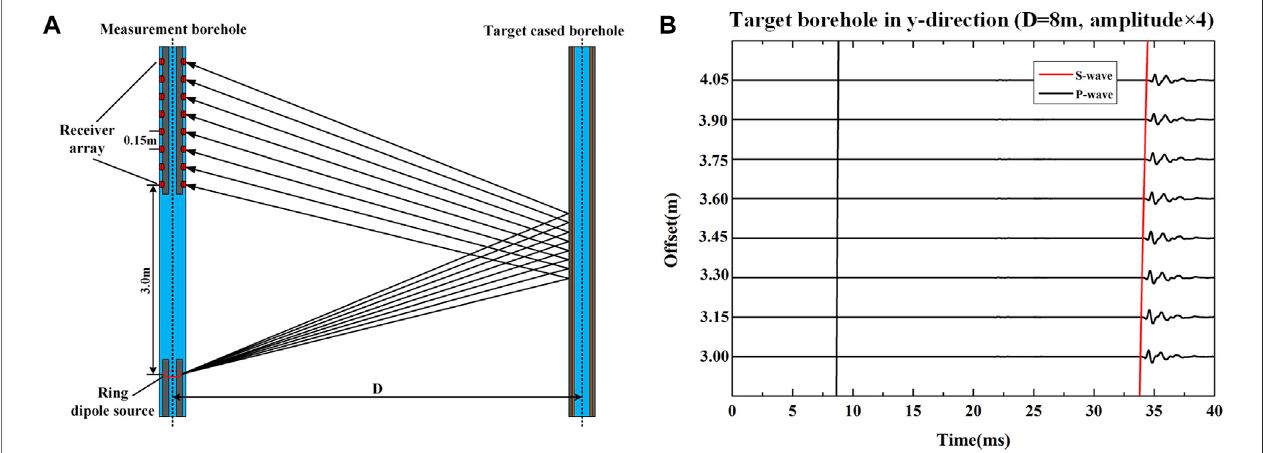
FIGURE 12 | (A) Schematic of the borehole detection model without motivating the Mach wave. (B) Pure scattered waves from the nearby cased borehole at the distance of 8 m when the target borehole orientation is perpendicular to the source orientation. The in fl uence on the scattered waves caused by the Mach wave is avoided by removing part of the drill collar as shown in (A)